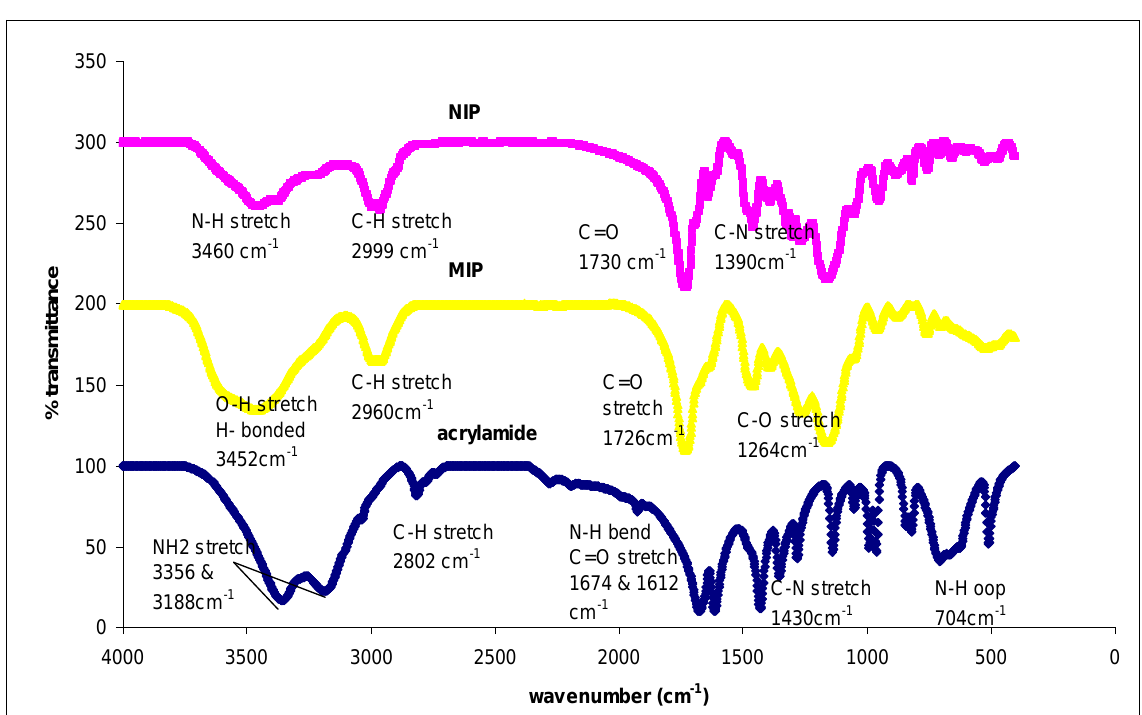
Figure 1. IR spectra for MIP, NIP and